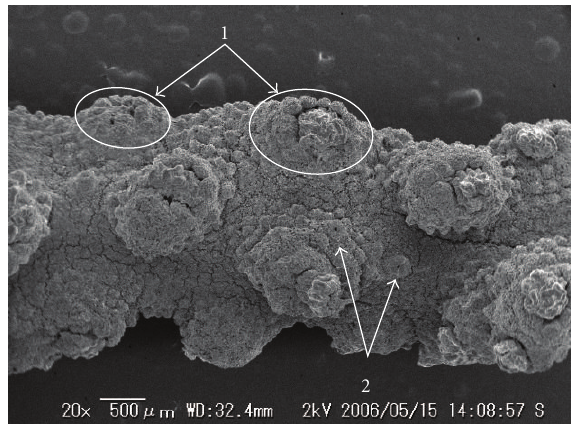
Figure 3: SEM image of coenenchyme surface of Paracorallium japonicum ; OCA-Cn20060211-031. 1: coenenchymal mounds, 2: siphonozooid projections.